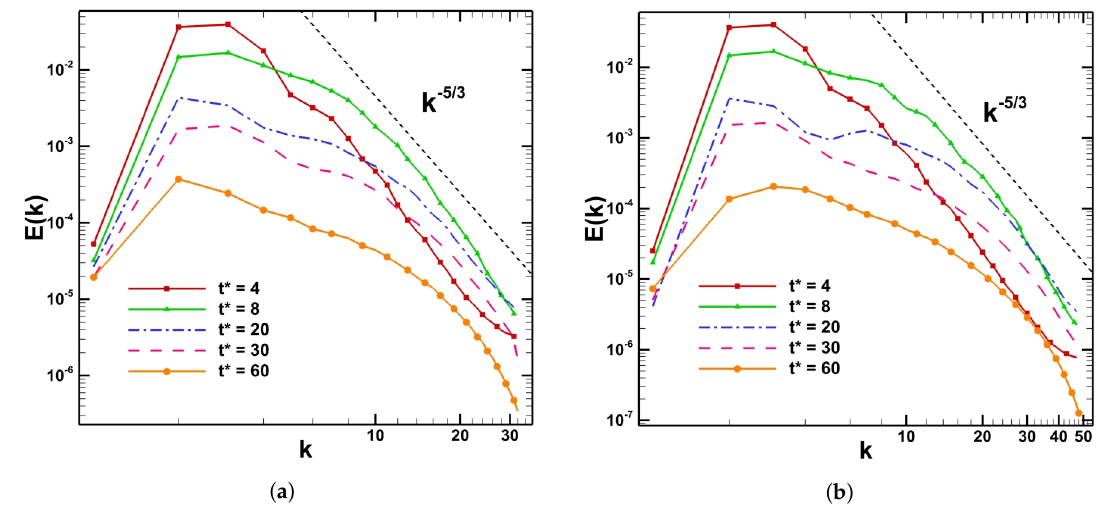
Figure 6. Kinetic energy spectra obtained using the MUSCL scheme with M3-KK slope limiter on 64 3 and 96 3 grids. ( a ) ILES, M3-KK (64 3 mesh); ( b ) ILES, M3-KK (96 3